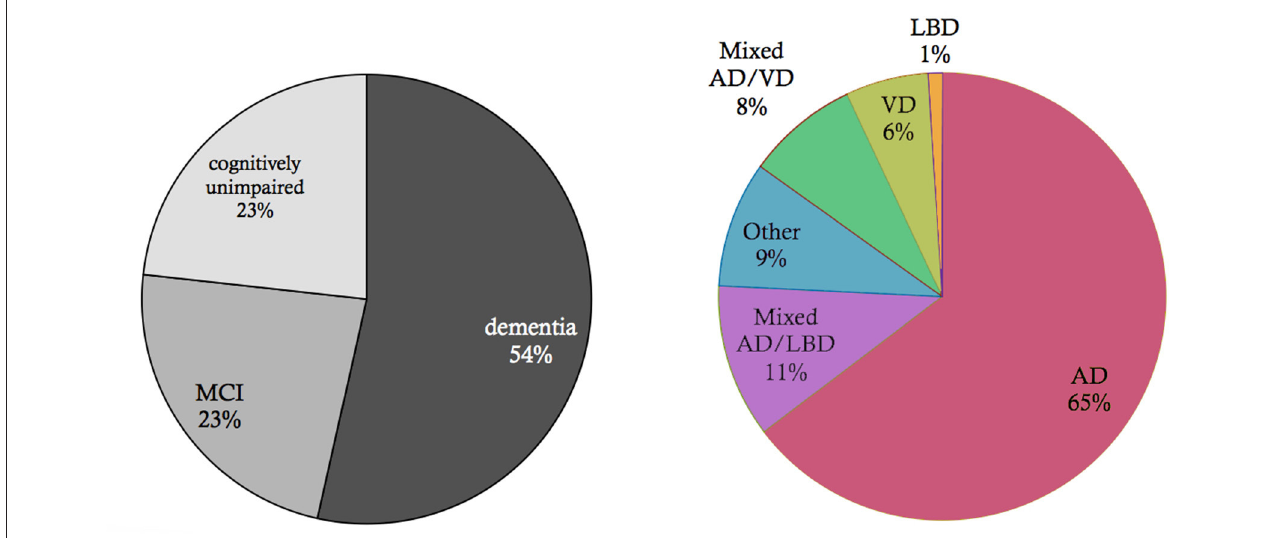
FIGURE 2 | Basic epidemiology of different types of dementia. Data and p -values from Robinson et al. (2018a). Shown is an elderly cohort ( n = 185) with a mean age of 97.7 years in an autopsy study. On the left, we see the prevalence of the cognitive states within this cohort at the time of death. More than half of the people suffered from dementia in this age group, while a quarter suffered from mild cognitive impairment (MCI), and another quarter had no cognitive disturbances. On the right, the clinical diagnosis ( ante mortem ) for the subpopulation that suffered from dementia is shown. Alzheimer’s Disease (AD) is the most prevalent form of dementia; however, mixed forms and other primary neurodegenerative dementias as synucleinopathies or frontotemporal lobar degeneration (FTLD) spectrum also play a role as well as vascular dementia (VD). In the post mortem analysis, the full cohort showed at least partial AD-related pathologic changes: 100% had neurofibrillary tangles of at least Braak stage I, and 63% had neuritic plaques. The mean Braak stage was in the dementia group 4.1, in the non-dementia group 3.2 ( p < 0.001). However, the dementia group also showed a significant higher Lewy-body pathology ( p = 0.018) and transactive response DNA-binding protein 43 kDa ( TDP-43 ) pathology ( p < 0.001) as well as a higher rate of definitive cerebrovascular disease ( p = 0.016). These findings indicate that in particular in the “super old,” different neuropathologic changes are probably concomitant and contribute to the development of cognitive decline in dementia—in contrast to the concept of “pure” AD as an isolated neurodegenerative